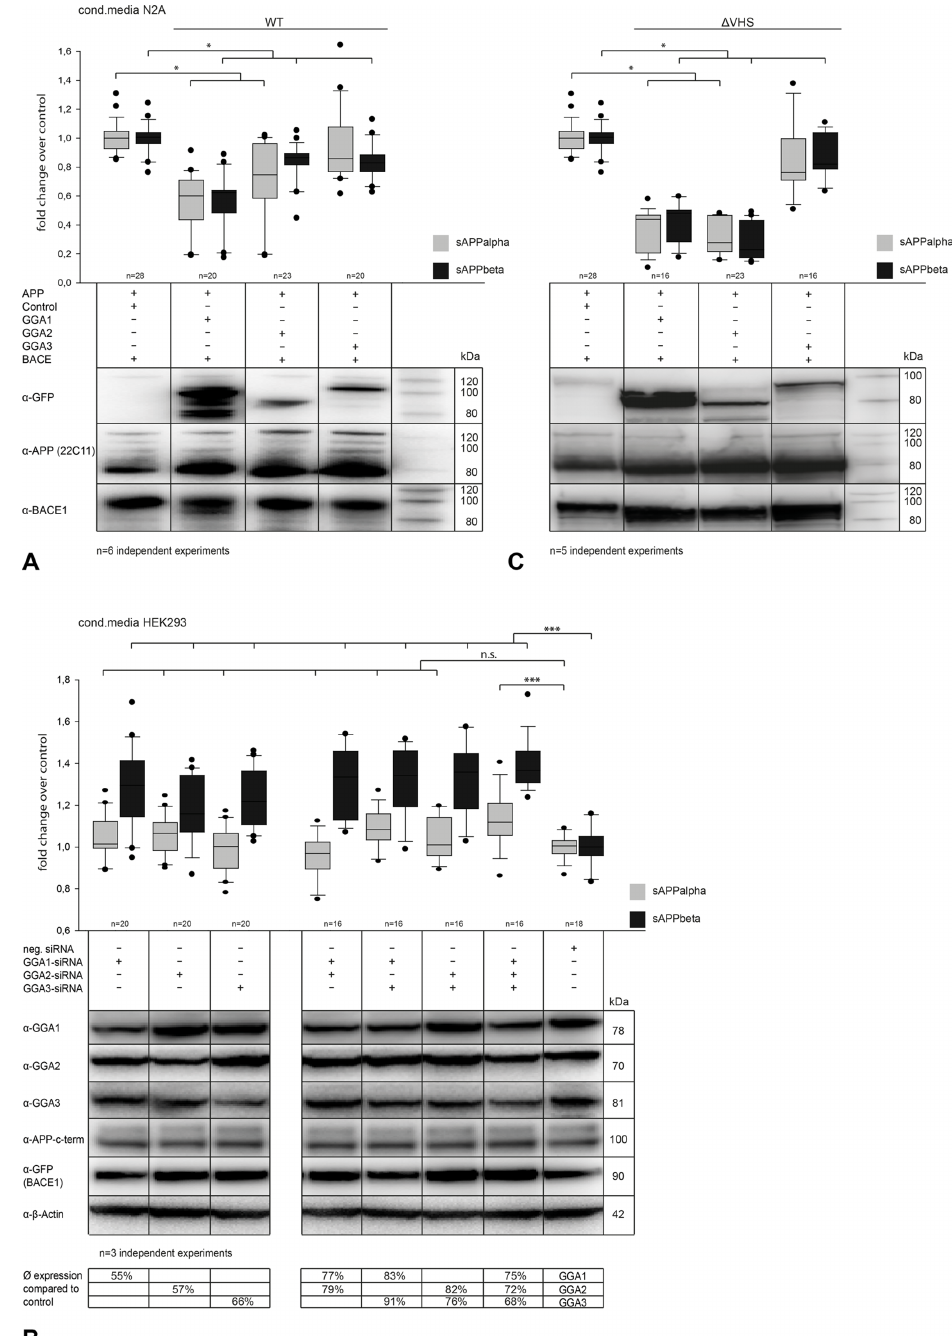
Fig 2. Regulation of GGA expression alters APP processing and sAPP secretion. (A) N2A cells were co-transfected with APP and BACE and either GGA1, 2, or 3. Equal expression of all proteins was controlled by Western blot analysis. We found, similar to the results in HEK293 (data not shown), significantly decreased levels of sAPP α and sAPP β in conditioned media upon GGA overexpression compared with control, as measured by ELISA. Experiments were carried out in triplicate; shown are the results of n = 6 independent experiments. Statistical analysis was performed by using Kruskal-Wallis one-way analysis of variance (ANOVA) on ranks and multiple comparison (Dunn ’ s method) ( * p < 0.05). (B) HEK293 cells were transfected with FlexiTube siRNA (Qiagen) and incubated for 48 h. siRNA-mediated knockdown of single GGAs in HEK293 cells led to increased sAPP β but not sAPP α levels compared with negative control.